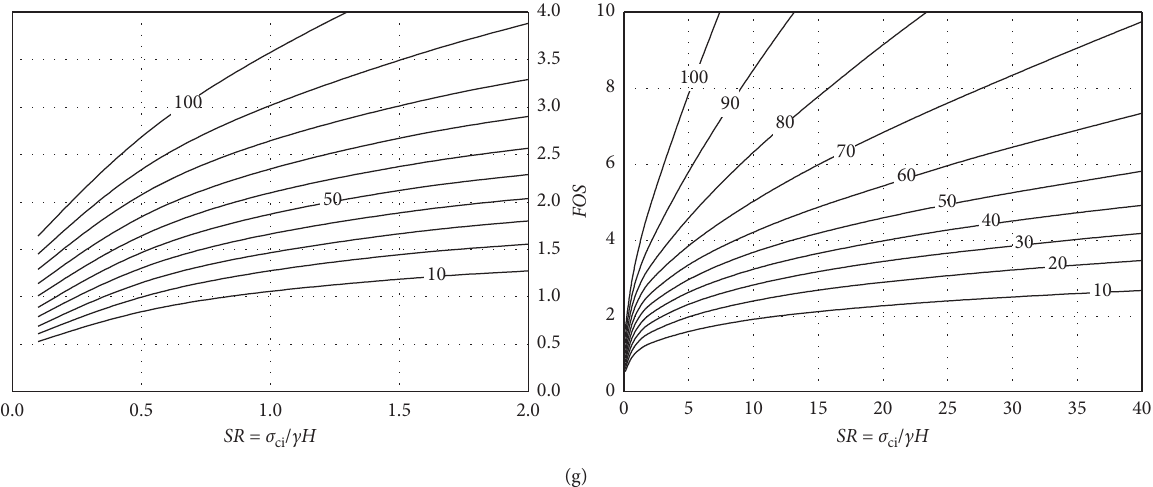
Figure 6: Stability charts for rock slopes with β � 45 ° under static conditions k (f) m i � 30; (g) m i � 35.